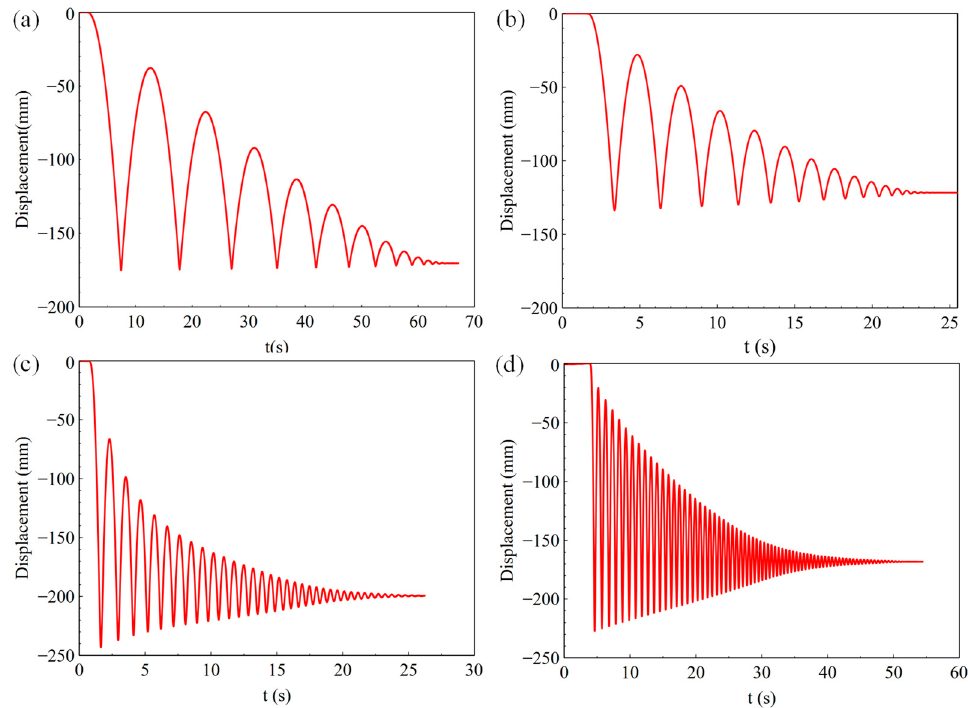
Figure 11. Displacement of the landing buffer tests with external force of ( a ) 0.98 N, ( b ) 9.8 N, ( c ) 98 N, ( d ) 196 N.